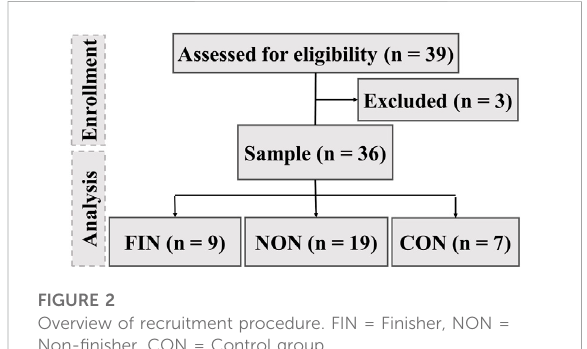
FIGURE 2 Overview of recruitment procedure. FIN = Finisher, NON = Non- fi nisher, CON = Control